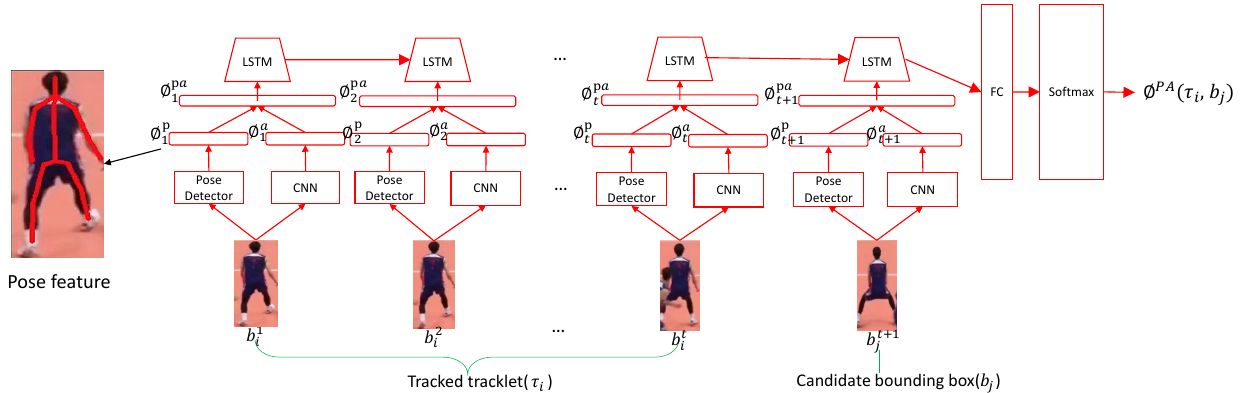
Figure 2. The architecture of Pose-based Appearance Stream (PAS). The inputs are τ i and b j . τ i is tracklet of i th athlete, composed of his bounding boxes from time 1 to t, and b j is a candidate detection at time t + 1. The concatenated features (i.e., pose features and appearance features) are fed into an LSTM followed by a softmax layer to generate the similarity score φ PA ( τ i , b j )